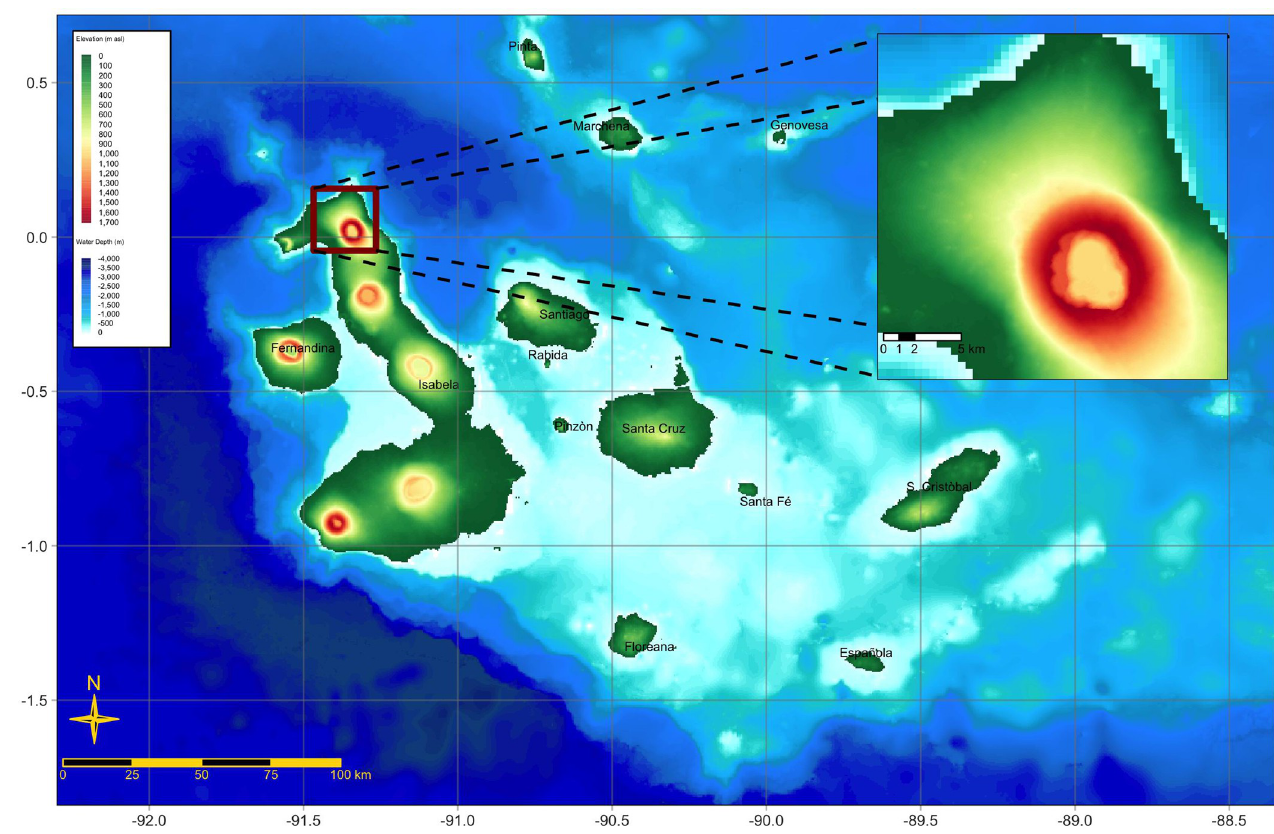
Fig 1. Map of the Gala´pagos archipelago. The archipelago is located � 1000 km off mainland Ecuador. The inset shows a detail of the northwestern slopes of Wolf Volcano, the only site where pink iguanas are known to persist.